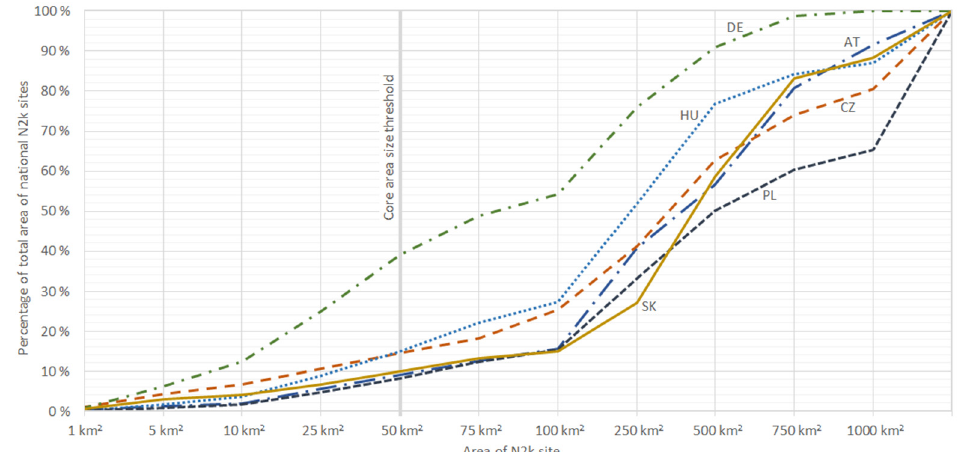
Figure 4. Cumulative area of N2k network in countries with respect to area of individual N2k sites. The GI network is less evenly distributed in the three remaining countries. Germany, together with Austria and Czechia, show the lowest proportion (around 15%) of their land covered by the GI network. In Germany, the core areas are on average the smallest and the differences in network density are visible between regions. A dense network of corri- dors occurred in the centre of Germany (Rhineland-Palatinate, Hesse, Thuringia) and in the north-eastern federal states (Mecklenburg-Vorpommern, Brandenburg) where nu- merous extensive N2k sites are located. In contrast, federal states with an overall lower coverage of N2k network (areal proportion of cores less than 10%) show a lower GI net- work density (e.g., Lower Saxony, North Rhine-Westphalia, Schleswig-Holstein). In Aus- tria and Czechia the spatial pattern of the network is rather sparse. Despite the fact total area of cores that reached the threshold of 50 km 2 is almost identical in both countries.